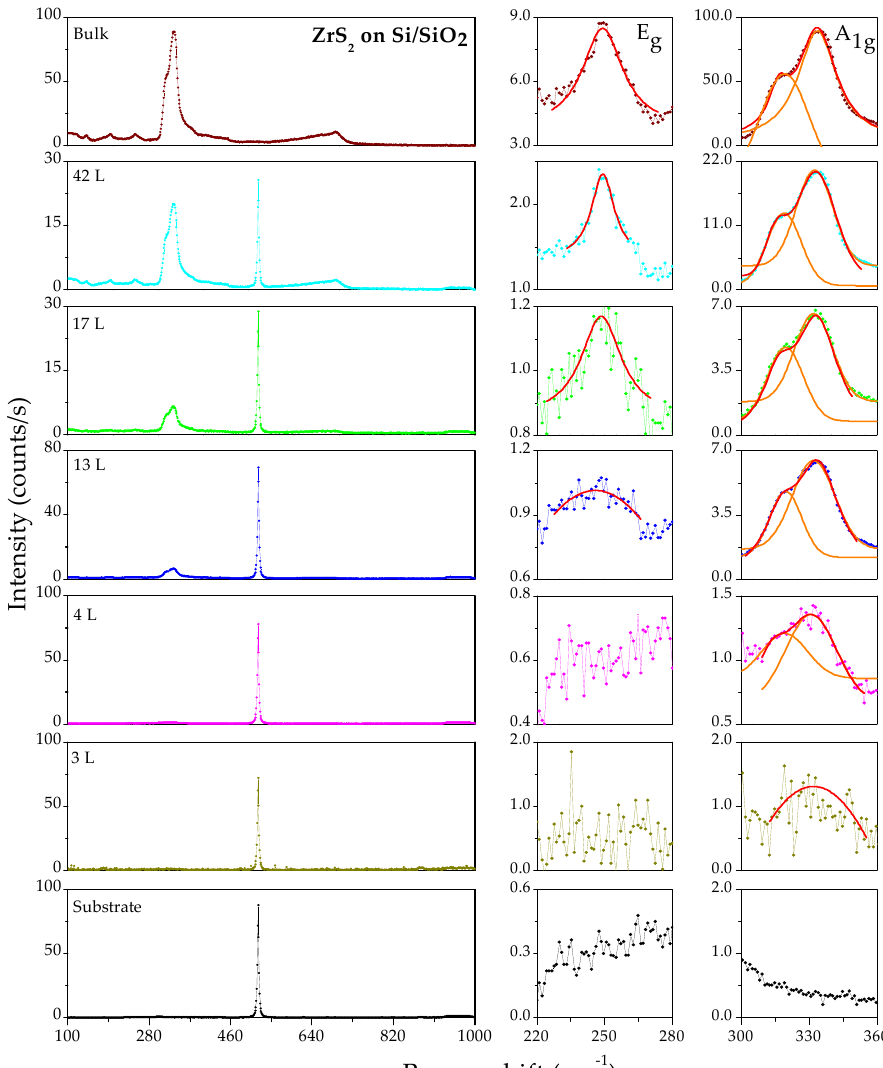
Figure C2 corresponds to the bare spectra (in counts/s) for ZrS 2 on a Si/SiO 2 substrate without the normalization to the Si phonon peak, in contrast to the spectra shown in Figure 3 and Figure C1a. The corresponding values for the fitting of the E g and A 1g are summarized in Table C1. Appl. Sci. 2016 , 6 , 264